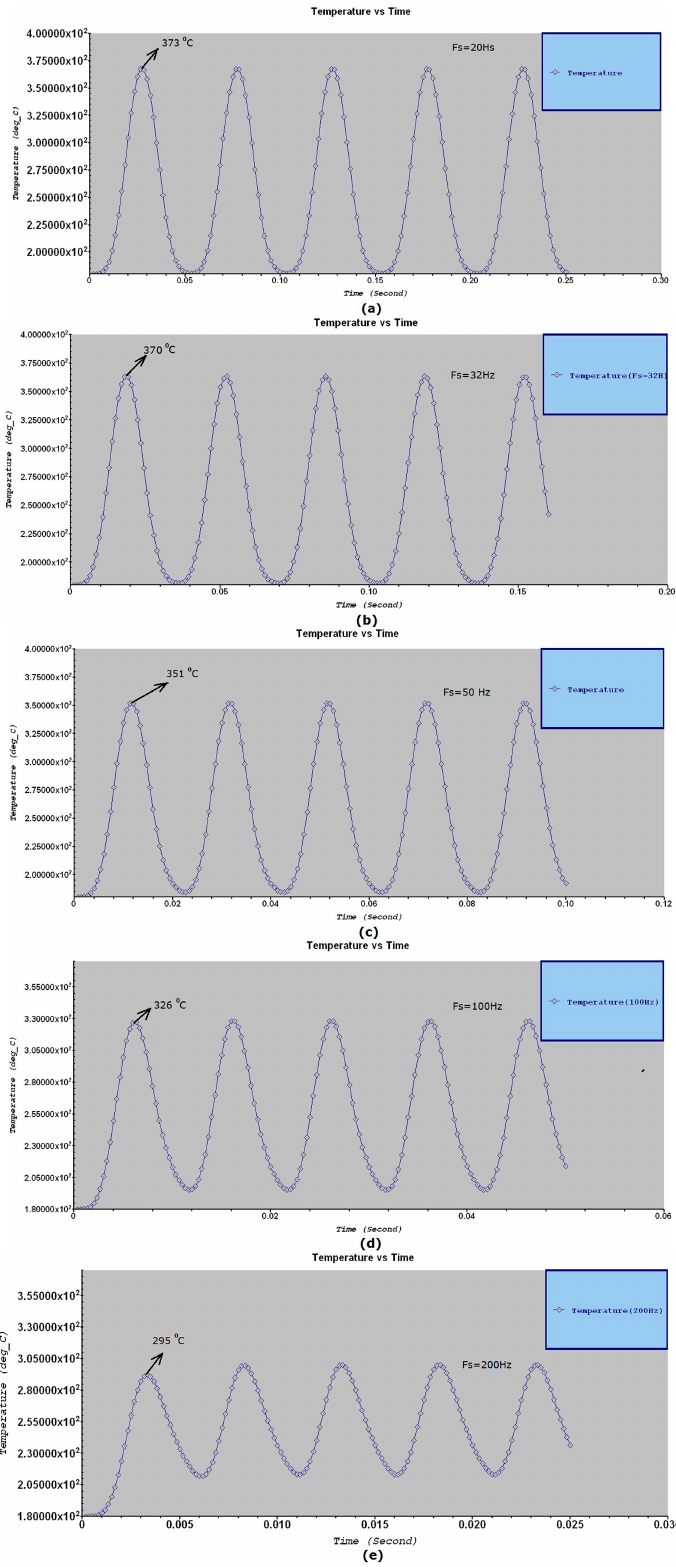
Figure 7. Temperature variation of the center shaft shown in Figure 5c: ( a ) Max Temperature = 373 °C with f = 20 Hz. ( b ) Max Temperature = 370 °C with f = 32 Hz. ( c ) Max Temperature = 351 °C with f = 50 Hz. ( d ) Max Temperature = 326 °C with f = 100 Hz. ( e ) Max Temperature = 295 °C with f = 200